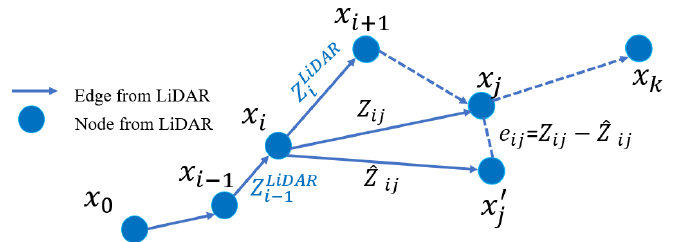
Figure 1. Demonstration of the graph generation based on LiDAR odometry. 200